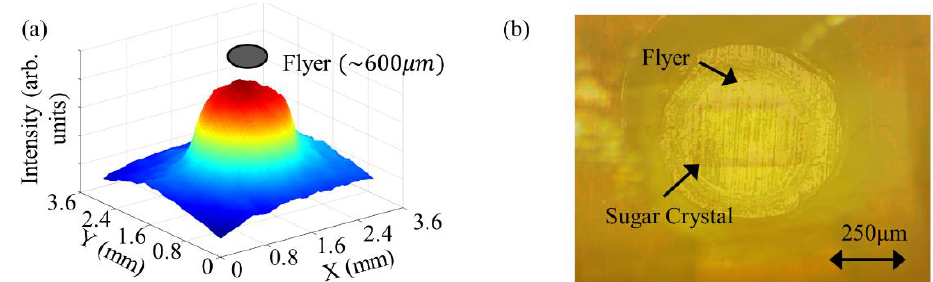
Fig. 3. (a) Profile of flyer launch laser at the launch pad (b) Assembly of flyer launch pad with PBS sample